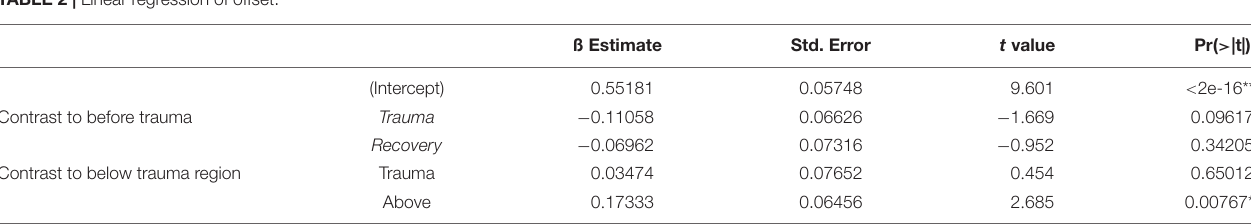
TABLE 2 | Linear regression of